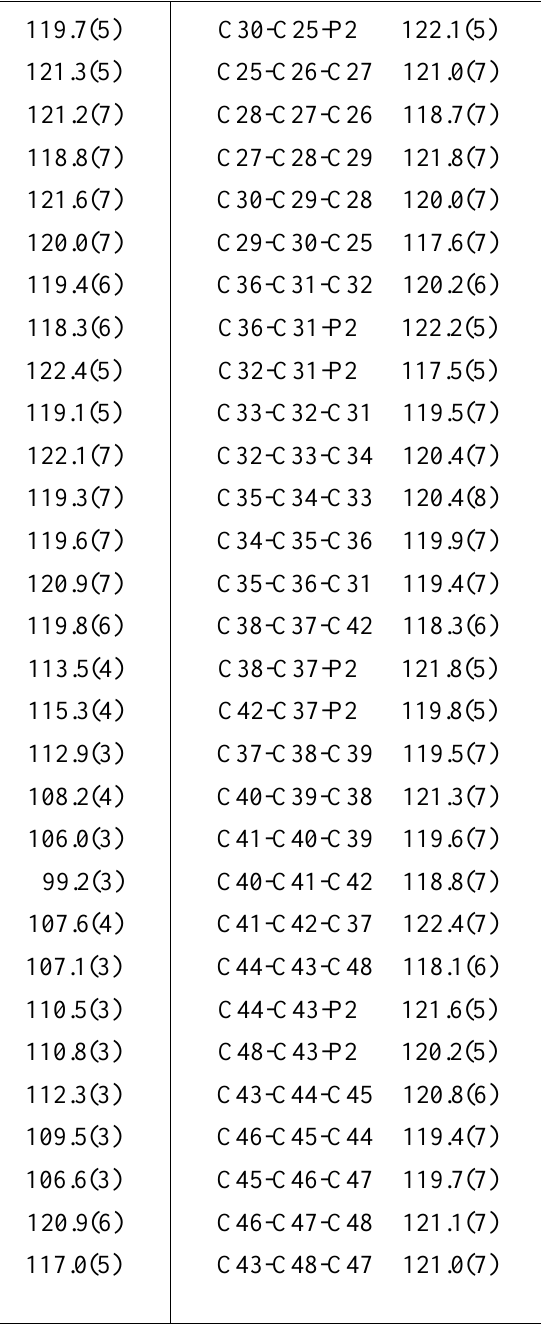
Table 3 . Bond angles [deg] for ( 4